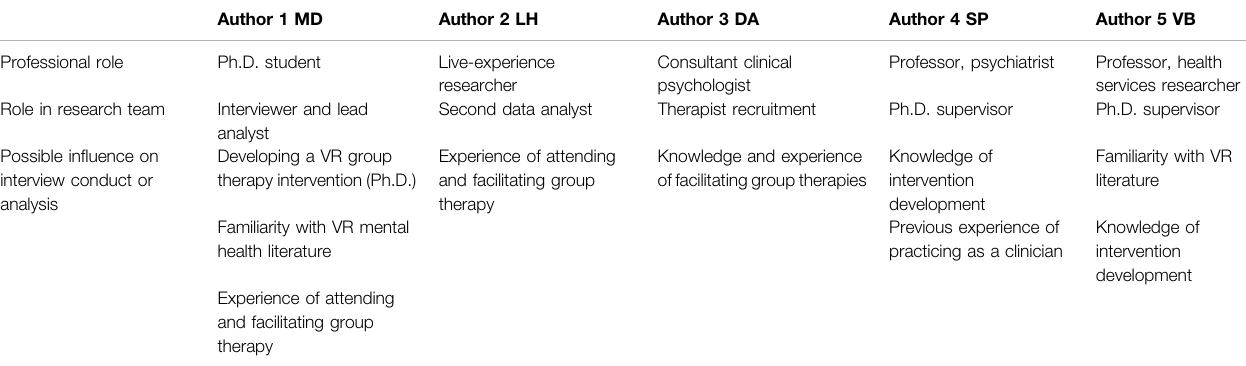
TABLE 1 | Researcher characteristics and re fl